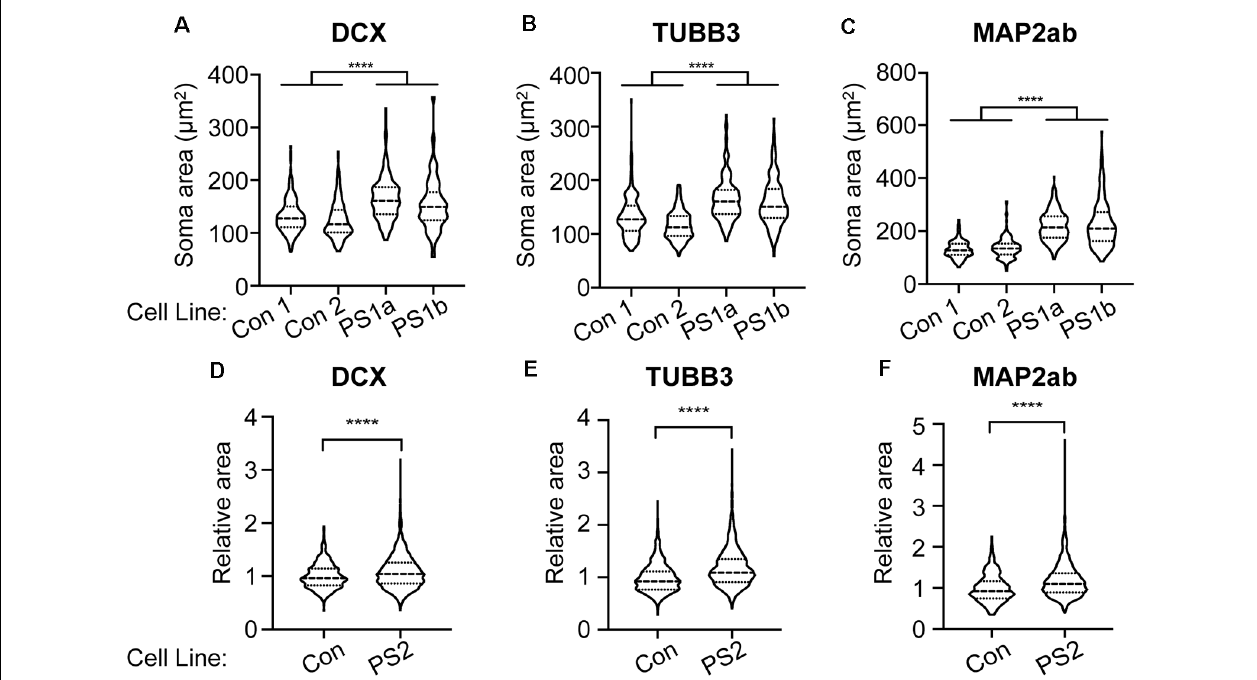
FIGURE 4 | PS iPSC-derived neurons have larger soma compared to control neurons. Soma size was measured for each experimental group using markers for immature (DCX, TUBB3) and mature (MAP2ab) neurons. Violin plots with quartiles are displayed. (A–C) Two control cell lines (Con) and two cell lines from PS subject 1 were quantified from two independent neuronal differentiations, and the data for each genotype were combined. (A) Neurons labeled for DCX. Con n = 432 PS 1: n = 438. (B) Neurons labeled for TUBB3. Con: n = 426, PS 1: n = 431. (C) Neurons labeled for MAP2ab. Con: n = 433, PS 1: n = 434. (D–F) Neuronal differentiations were repeated using a separate control cell line (Con) and one cell line from PS subject 2 (PS 2). For each differentiation, soma size was normalized to the control neurons to account for batch to batch variation. Two independent neuronal differentiations were quantitated for DCX (D) and four independent differentiations were quantitated for TUBB3 (E) and MAP2ab (F) . (D) Neurons labeled for DCX. Con: n = 563, PS 2: n = 1,711. (E) Neurons labeled for TUBB3. Con: n = 866, PS 2: n = 2,430. (F) Neurons labeled for MAP2ab. Con: n = 430, PS 2: n = 1,944. Statistical analysis was performed using an unpaired Student’s t -test with Welch’s correction. **** p <